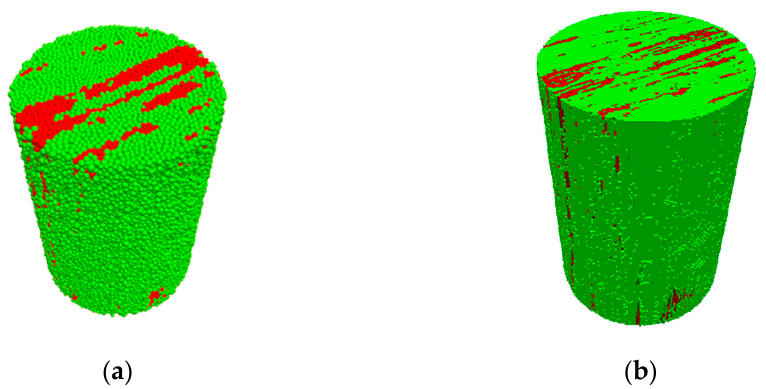
Figure 4. Particle-based ( a ) and corresponding continuum-based ( b ) model C1 (green: matrix; red: inclusions; holes: pores).